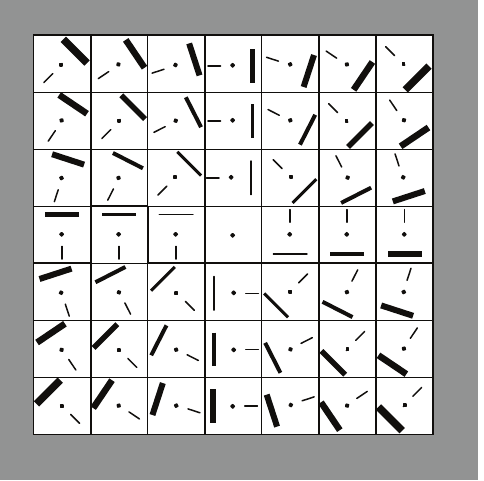
Figure 4 Rays traversing the lens of Figure 3. The dots in the centres of the squares represent incident ray segments orthogo- nal to and on this side of the lens. The arrows represent the emergent segments on the other side of the lens. The emergent segments exhibit a clockwise swirling pattern as one travels with the light. The central dot represents the optical axis. The chi- rality is reversed in the case of a thin lens of power L D. The arrows can also be viewed as constituting a vector